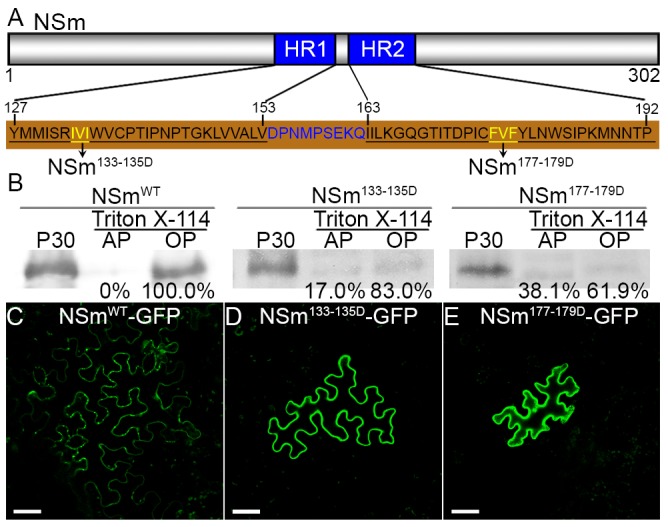
Impairment of membrane integration of NSm inhibits its cell-to-cell movement in leaf epidermis of N. benthamiana.(A) Diagram of amino acid residues for hydrophobic regions (HR1 to HR2) and two aspartate substitution mutants at sites of amino acids 133–135 and 177–179 in NSm. (B) Triton X-114 partitioning analysis of NSm133-135D and NSm177-179D aspartate substitution mutants. P30 pellet, aqueous phase (AP) and organic phase (OP) were analyzed by immunoblots using anti-NSm antibodies, respectively. (C-E) Cell-to-cell movement analysis of NSm133-135D (D) and NSm177-179D (E) mutant in N. benthamiana after bombardment. NSmWT (C) was used as a positive control. Bar, 50 μm.